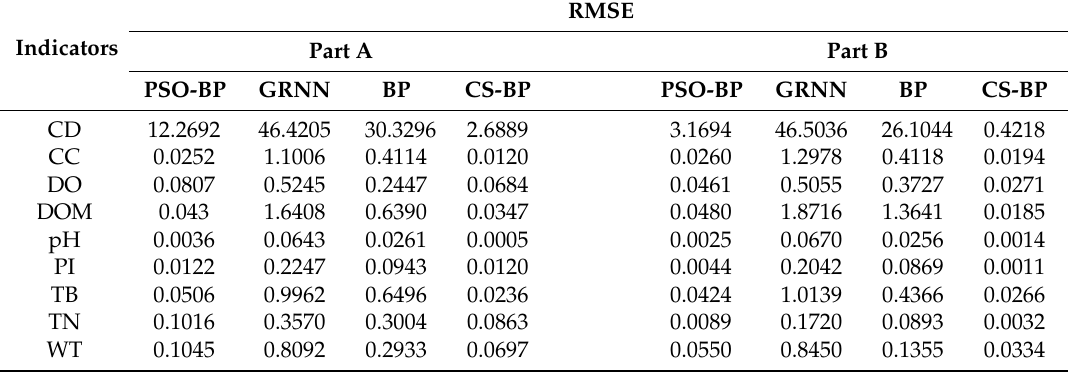
Table 7. The RMSE of water quality indicators of four models in different data proportions in Scenario 3.